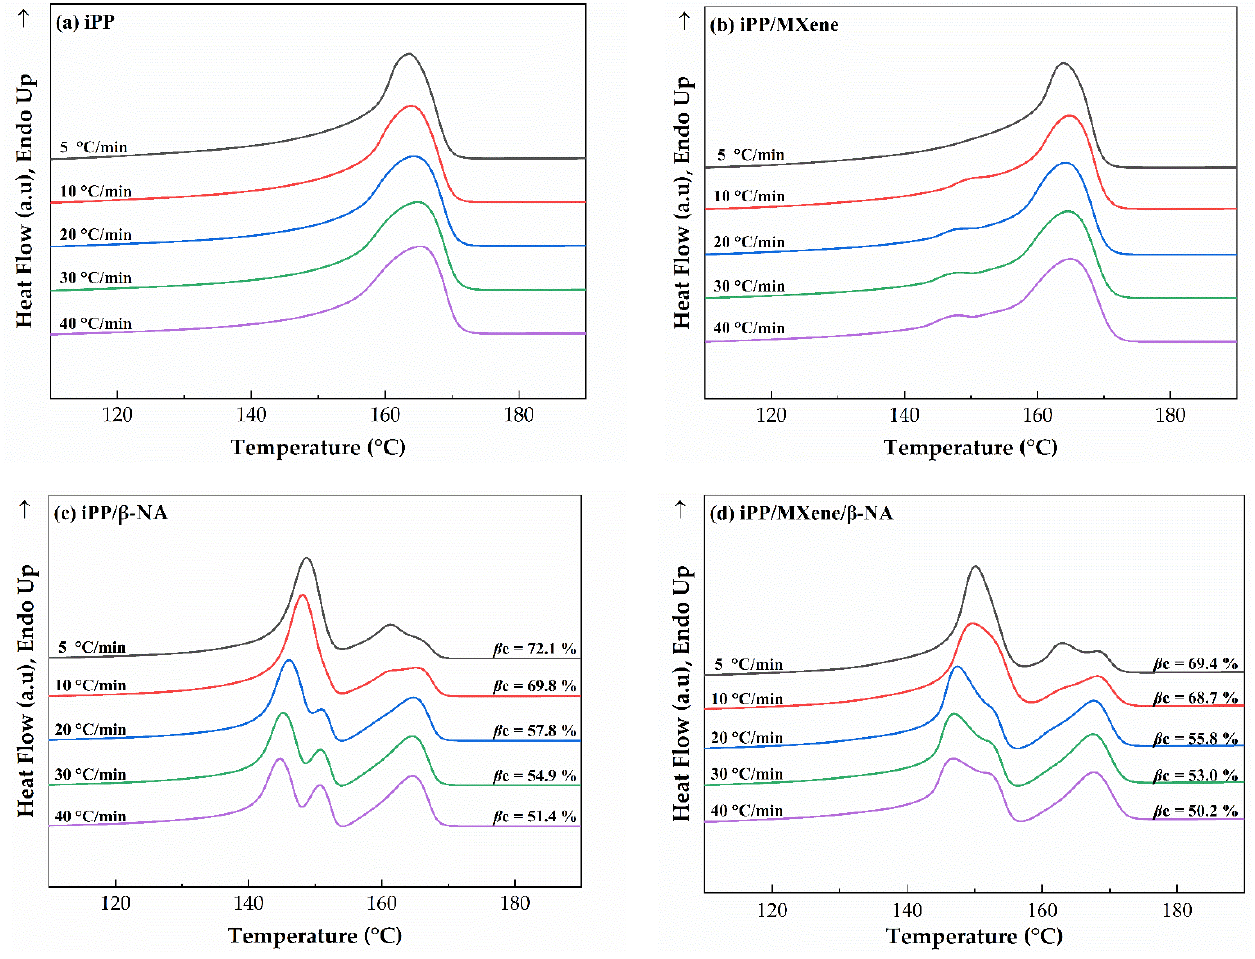
Figure 9. DSC melting curves of ( a ) neat iPP, ( b ) iPP/MXene, ( c ) iPP/ β -NA, and ( d ) iPP/MXene/ β -NA at cooling rates 5, 10, 20, 30, and 40 °C/min.